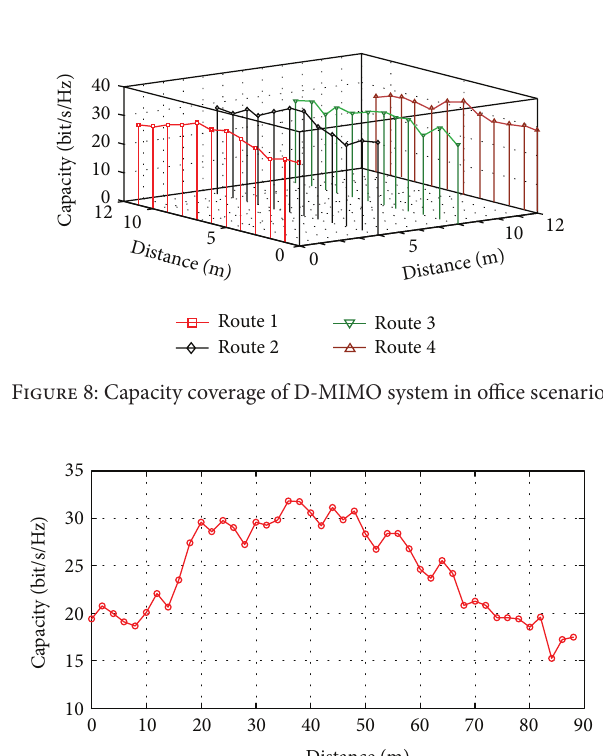
Figure 7: Eigenvalue distributions at selected positions in (a) office and (b) corridor scenarios.